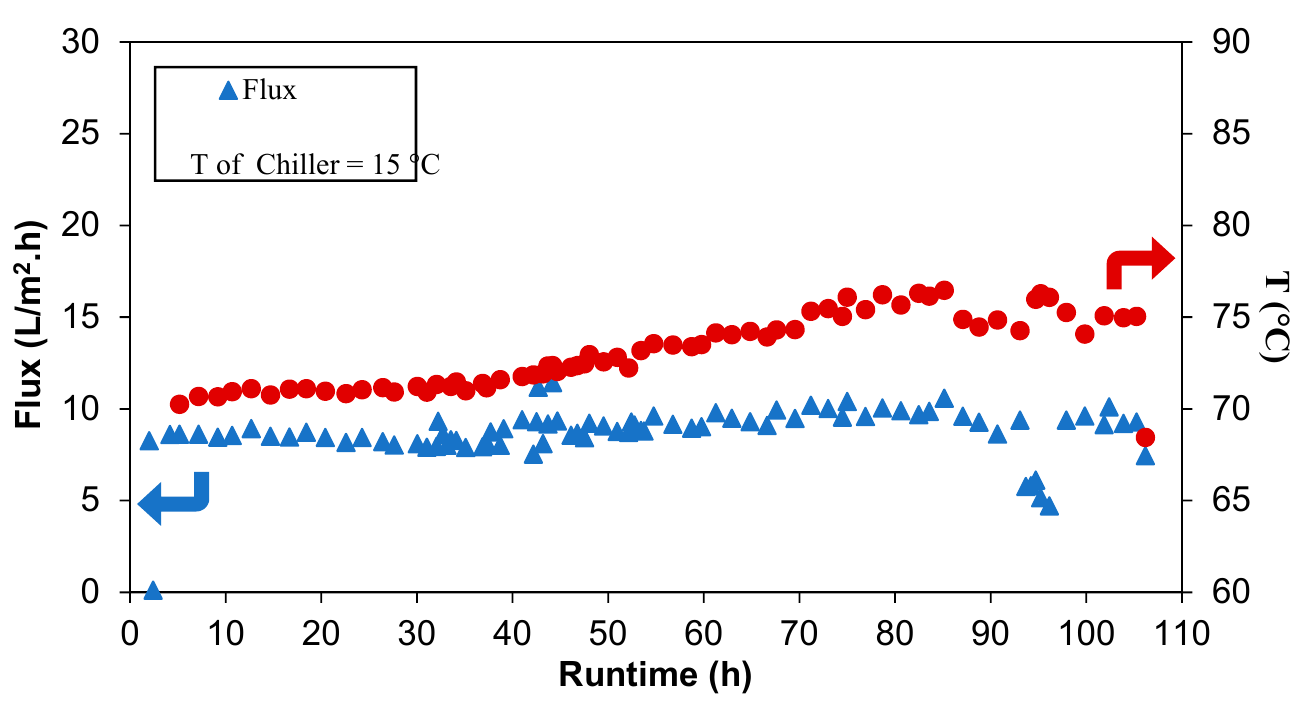
Figure 9. Flux and feed temperature profile from pilot tests using a 2-inch module.